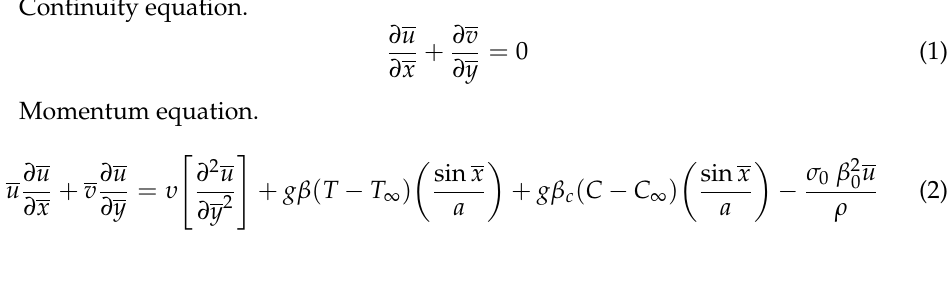
Figure 1. Physical model of the problem. Under the main assumptions of the law of conservation of mass, momentum and energy, the boundary-layer dimensional equations according to Boussinesq boundary-layer approximation are valid as shown below. Continuity